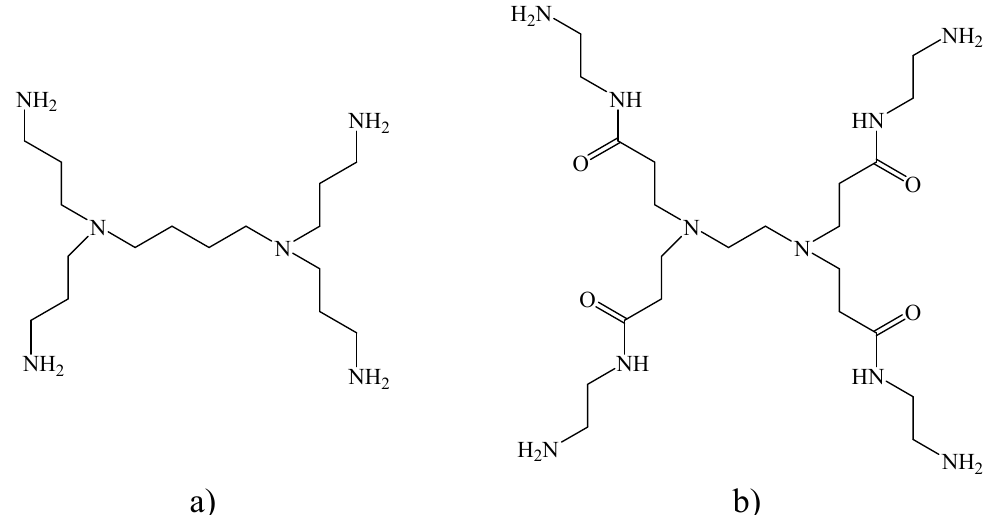
Figure 13. Chemical structures of ( a ) diaminobutane (DAB), and ( b ) polyamidoamine (PAMAM).